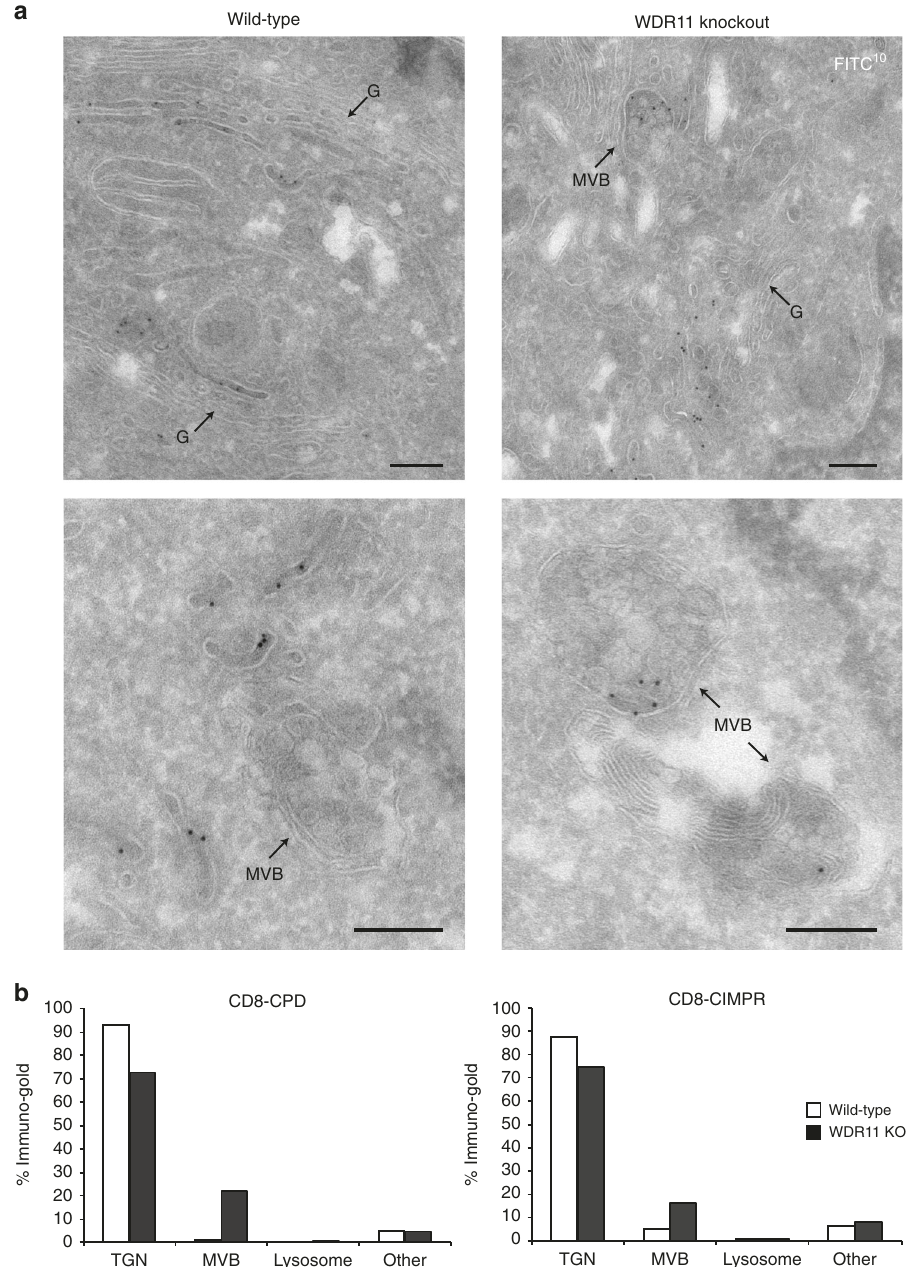
Fig. 5 Accumulation of cargo in MVBs in WDR11-knockout cells. a CD8-CPD-expressing cells were allowed to endocytose FITC-conjugated anti-CD8 for 3 h, then the endocytosed antibody was localised with anti-FITC using immunogold on cryosections. G: Golgi stacks; MVB: multivesicular bodies. Scale bars: 200 nm. b Quanti fi cation of EM images from wild-type and WDR11-knockout cells stably expressing either CD8-CPD or CD8-CIMPR. Every gold particle was assigned to an organelle and the percentage labelling per organelle calculated ( N = 35 cells per cell line). Antibody accumulation in MVBs only occurred in the knockout